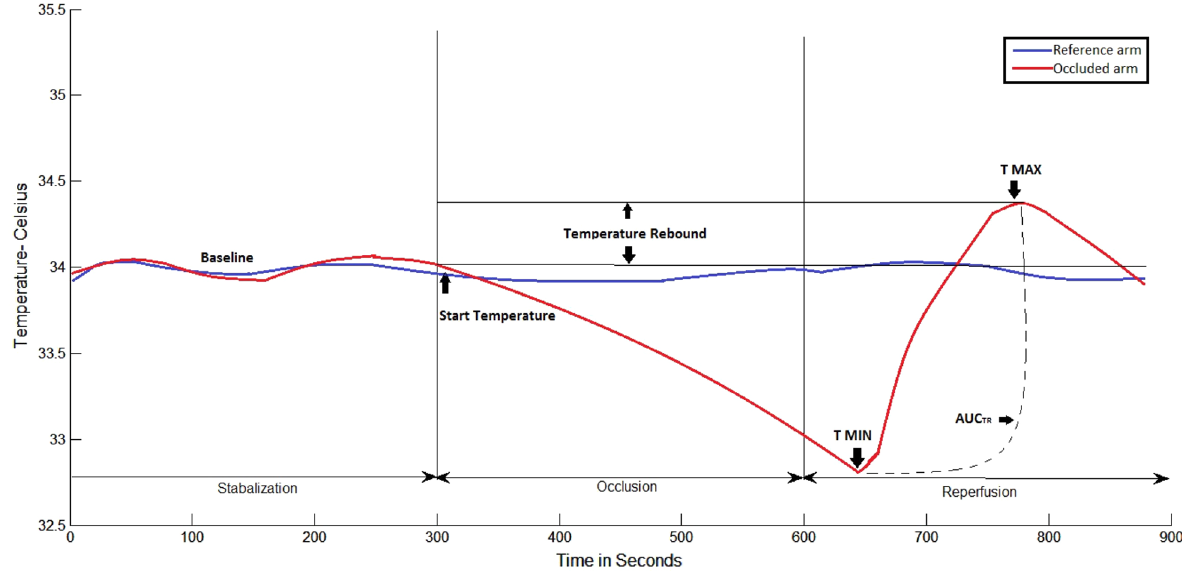
Figure 2 . Graphical representation of the Digital Thermal Monitor software analysis. T MAX, maximum temperature; TMIN, minimum temperature; AUCTR, Area under the curve